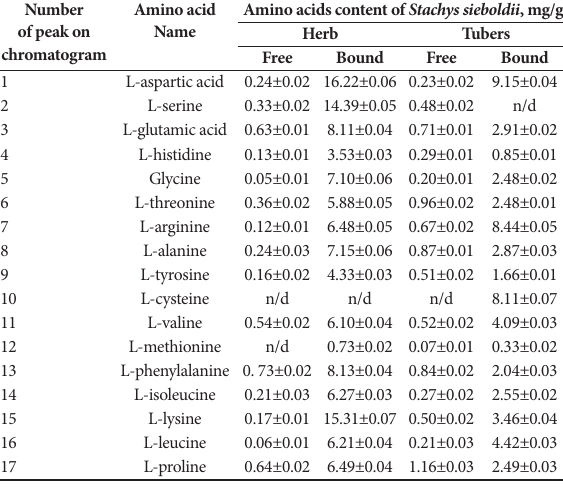
Table 3. The amino acid composition content of Stachys sieboldii .